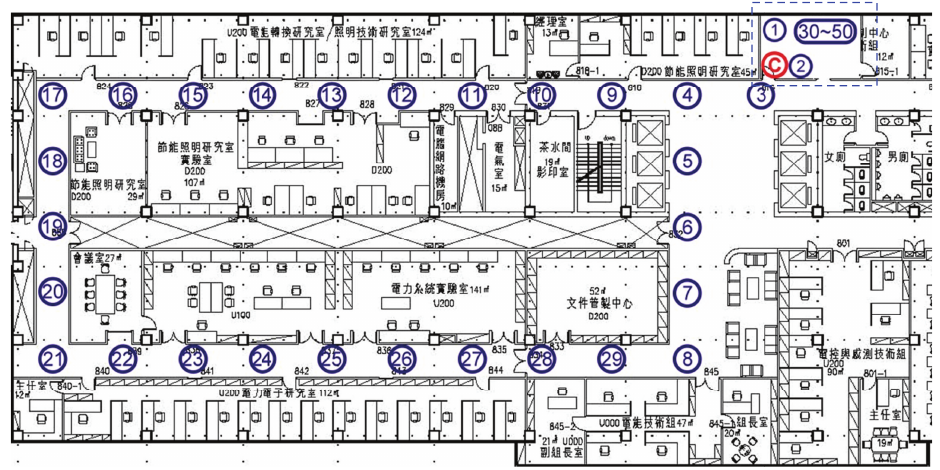
Figure 6: The deployment layout for sensor